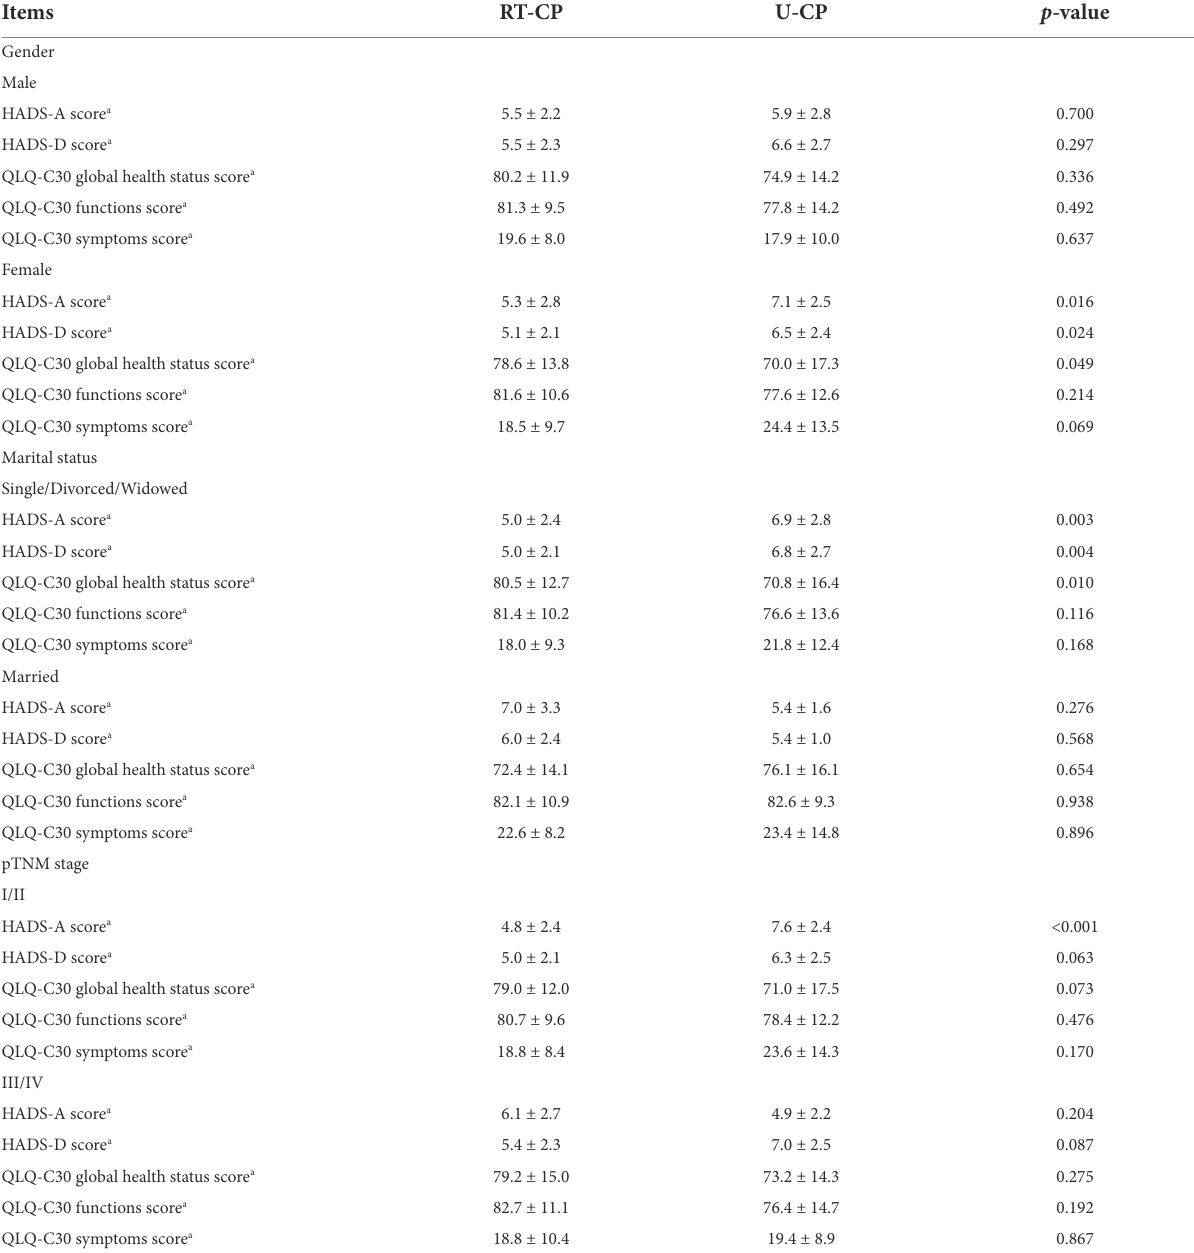
TABLE 4 Subgroup analysis of outcomes at M6 among the older PTC